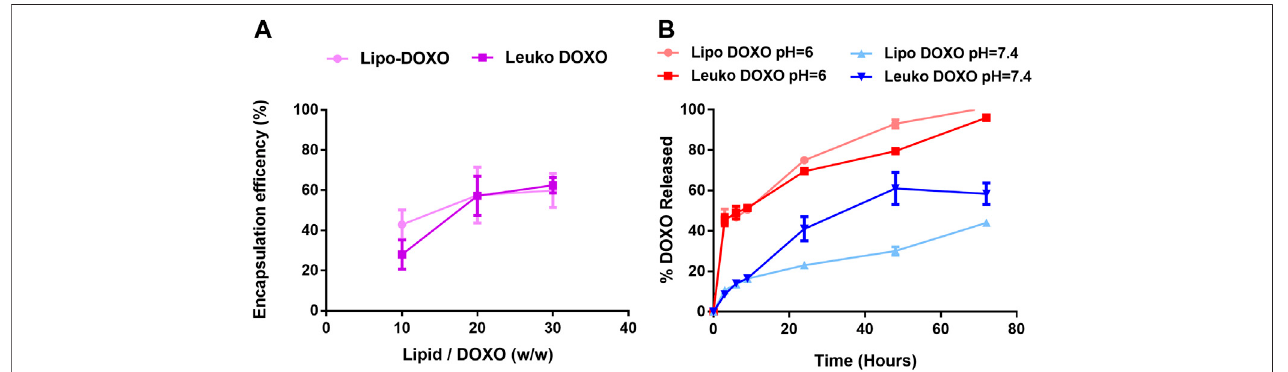
FIGURE 5 | (A) Encapsulation ef fi ciency of DOXO pro fi le for Lipos and Leukos at different lipids to DOXO ratios. (B) DOXO release pro fi le from Lipo-DOXO and Leuko-DOXO at pH = 7.4 and pH = 6 ( n = 3 for all the performed